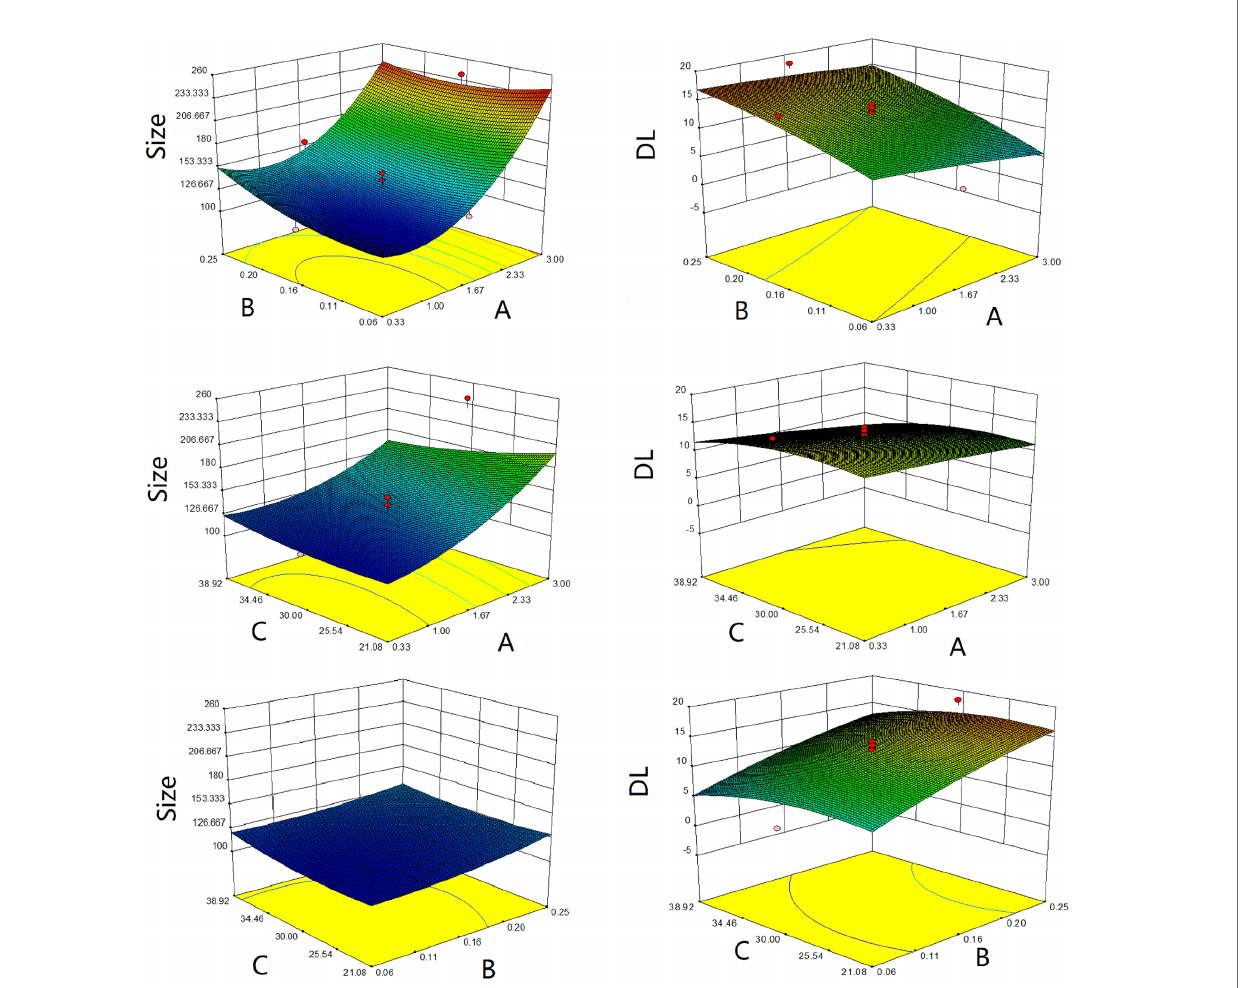
FIGURE 6 | Response surface diagrams of CHOL : HSPC ratio (A) , CHE drug – lipid ratio (B) and drug incubation time (C) to size and drug loading ef fi ciency